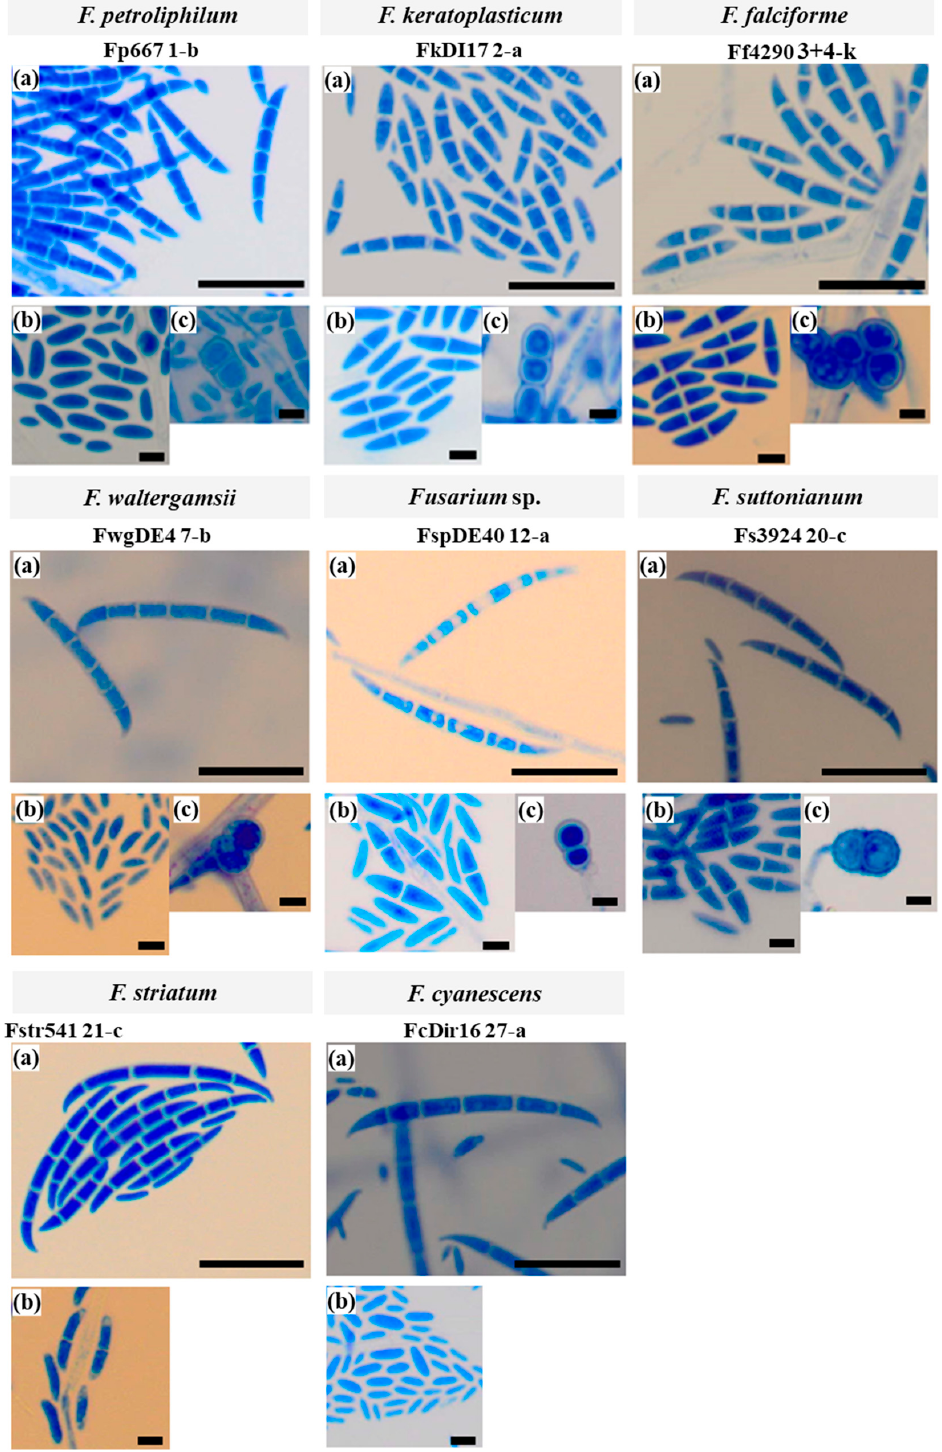
Figure 3. Microscopic images at 40× magnification of eight FSSC isolates representing the eight species identified among the collection of the 30 Malaysian FSSC isolates. Cells were grown on CLA at 28 °C for four to seven days with alternating 12 h light and 12 h dark periods. Cells were stained with lactophenol cotton blue. Macroconidia (a; scale bar: 100 μ m), microconidia (b; scale bar: 20 μ m), and chlamydospores (c; scale bar: 20 μ m).